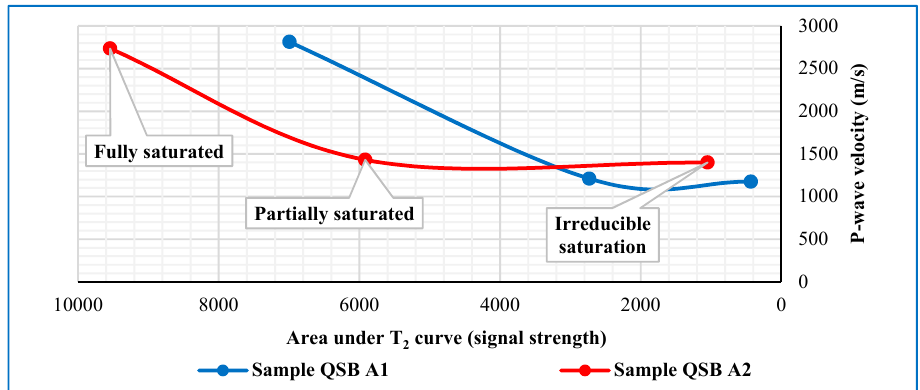
Figure 5. The relationship between the changes in the elastic and NMR responses of the two coal core samples in the laboratory. Three data points from left to right respectively indicate the fully saturated, partially saturated, and irreducible saturation states.